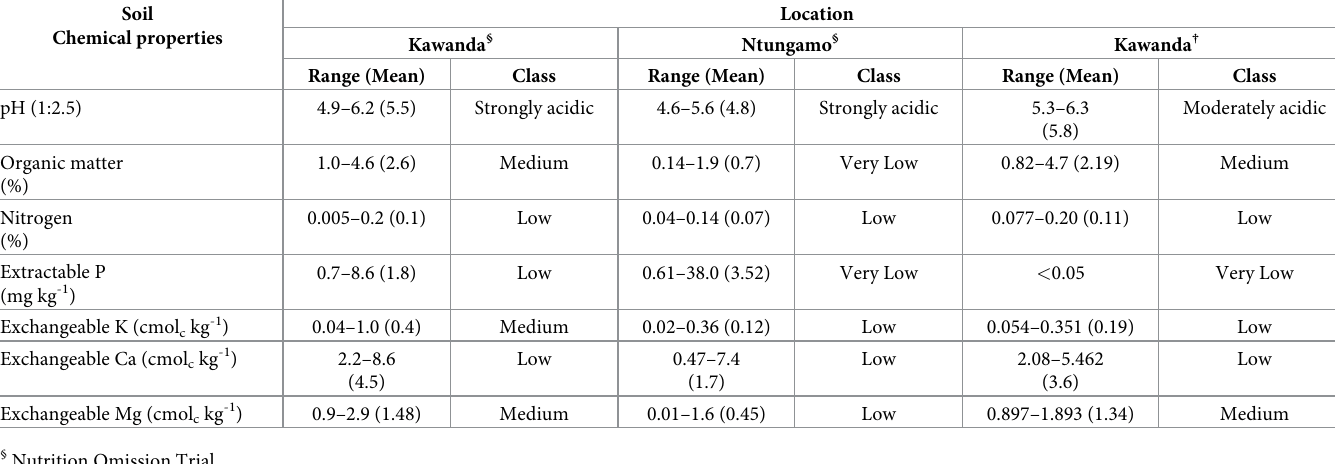
Table 1. Chemical properties of the top 30 cm of soils in the experimental sites.